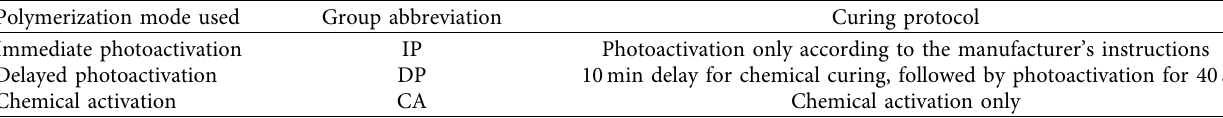
Table 2: Experimental groups and curing protocols used in the present